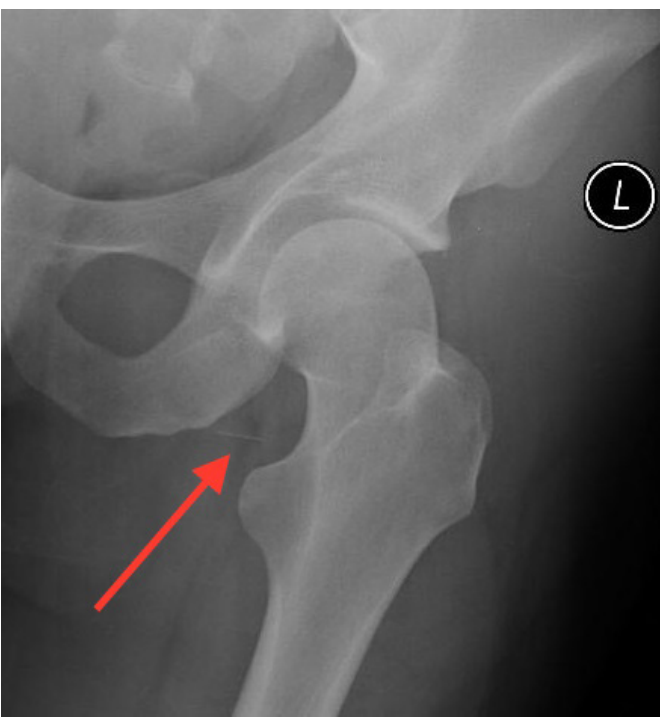
Figure 2. Linear foreign body (arrow) in the groin as seen on plain